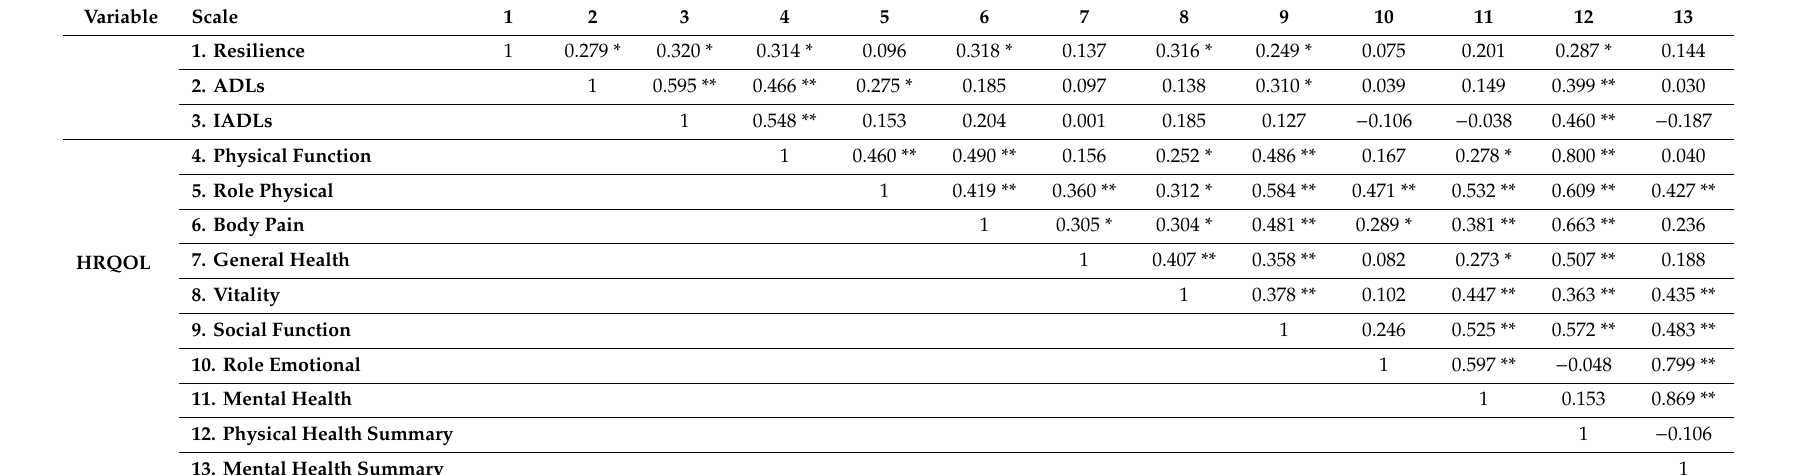
Table 2. Patterns of correlations between resilience, ADLs, IADLs and components of HRQOL (* p < 0.05; ** p <